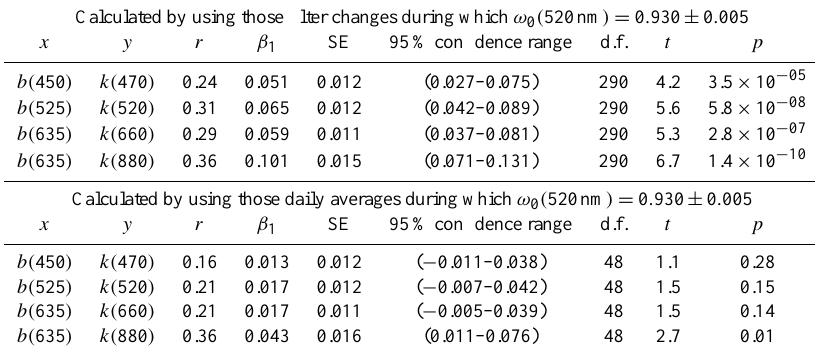
Table 3. Regression statistics ( y = β 1 x + β 0 ) of compensation parameter vs. backscatter fraction at a limited single-scattering albedo range. Detailed column description as in Table 1.